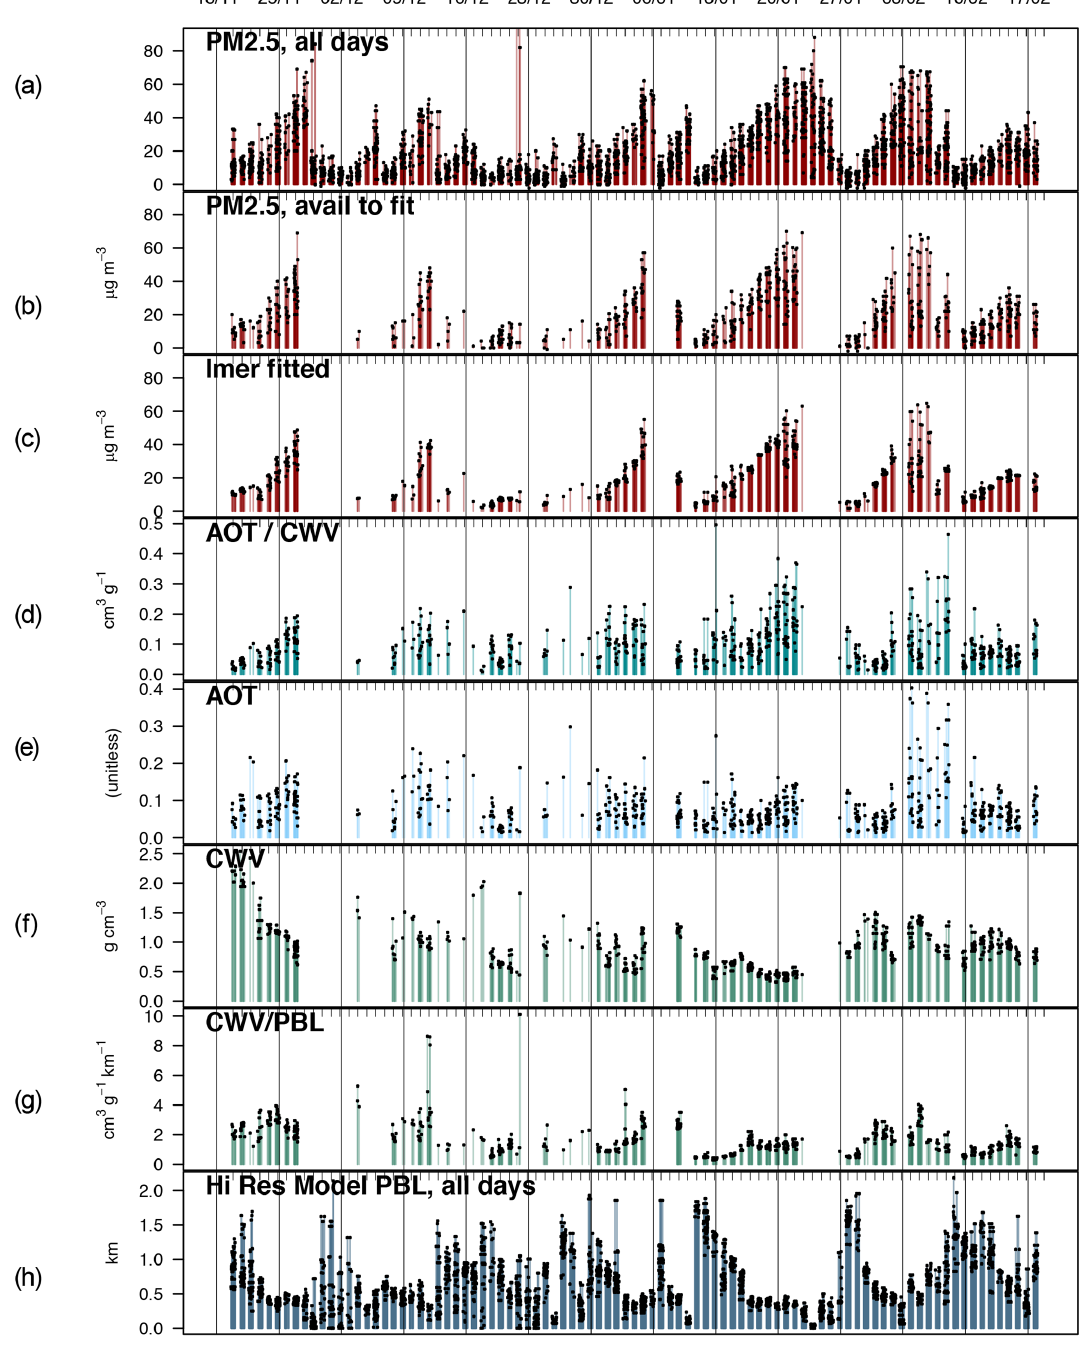
Figure 7. Time evolution of PM 2 . 5 and related variables for approximately eight intensifying particulate episodes during the winter of 2012– 2013. Dots and vertical bars indicate variable values at individual stations when available. Blank regions reflect periods of cloud cover. (a) PM 2 . 5 (µgm − 3 ) as observed at stations (all dates) and (b) fitted PM 2 . 5 on days and locations when MAIAC was available. (c) MAIAC AOT, 11:30 to 15:30UTC. Note that the increase is less pronounced than PM 2 . 5 and varies between episodes. (d) CWV in gcm − 2 or, colloquially, “cm of precipitable (liquid) water.” (e) PBL height for the noon–afternoon observations in this dataset. Morning PBL heights are much lower. (f) Ratio of CWV to PBL height (cm(H 2 O-liq)km − 1 ). The ratio remains relatively constant over several days, consistent with a commonly close meteorological relationship of CWV and